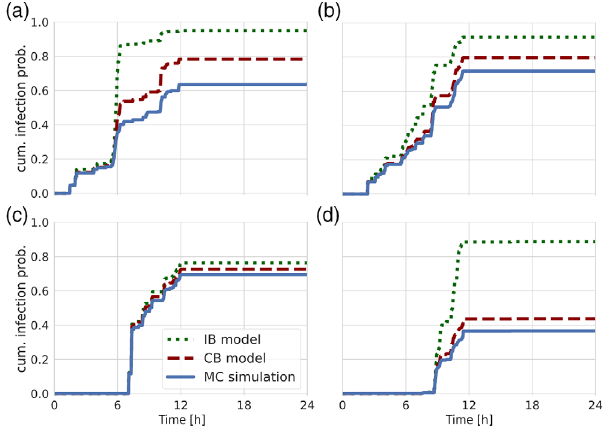
FIG. 2. Epidemic trajectories for four exemplary individual nodes. We compare the cumulative infection probability from MC simulations (blue line) with estimations from the CB model (red dashed line) and the IB approach (green dotted line). Simulated results are averaged over 10 4 MC realizations with the same outbreak location and disease parameters as in Fig.